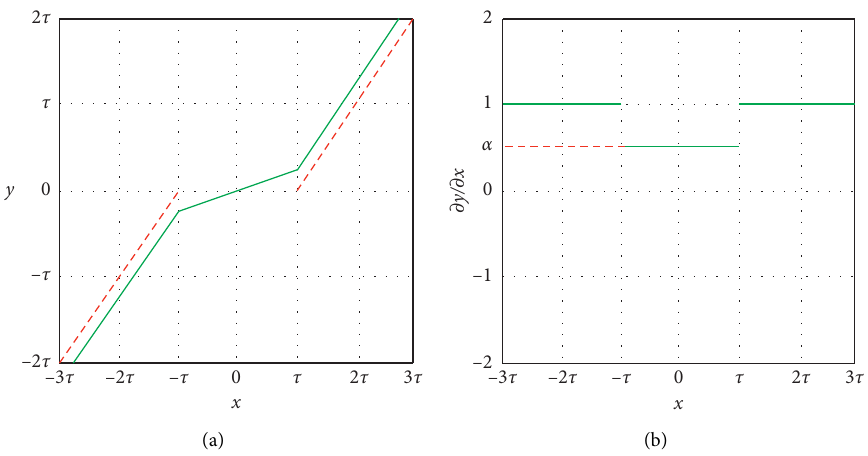
Figure 3: (a) Leaky-thresholding illustration and (b) its derivative illustration.